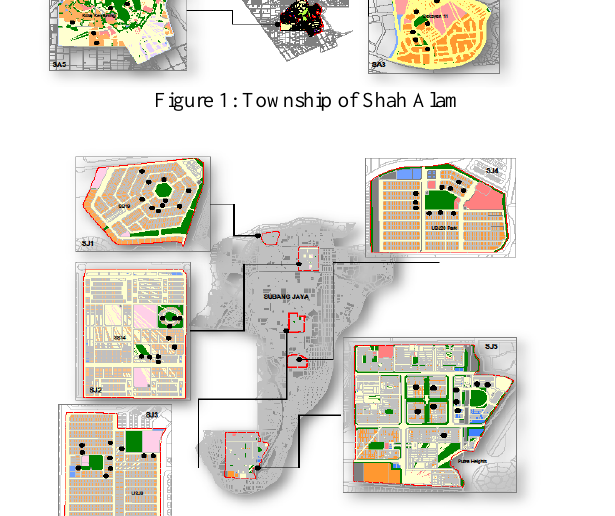
Figure 2: Township of Subang Jaya